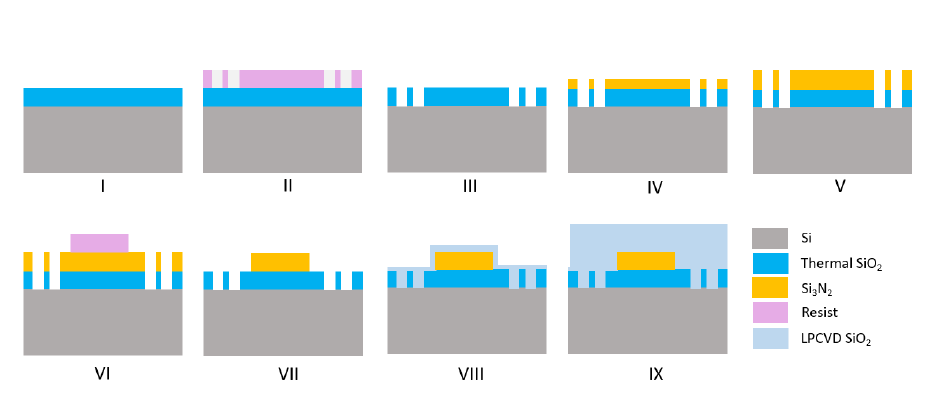
Figure 3. Multistep annealing process flow: ( I ) thermal oxidation, ( II ) photolithography, ( III ) SiO 2 HF etch, ( IV ) Si 3 N 4 deposition and annealing at 1100°C, ( V ) second Si 3 N 4 , ( VI ) E-beam lithography, ( VII ) Si 3 N 4 etch, ( VIII ) LPCVD SiO 2 deposition and annealing at 1100°C and ( IX ) PECVD SiO 2 deposition. Reprinted with permission from [31], ©2019 The Optical